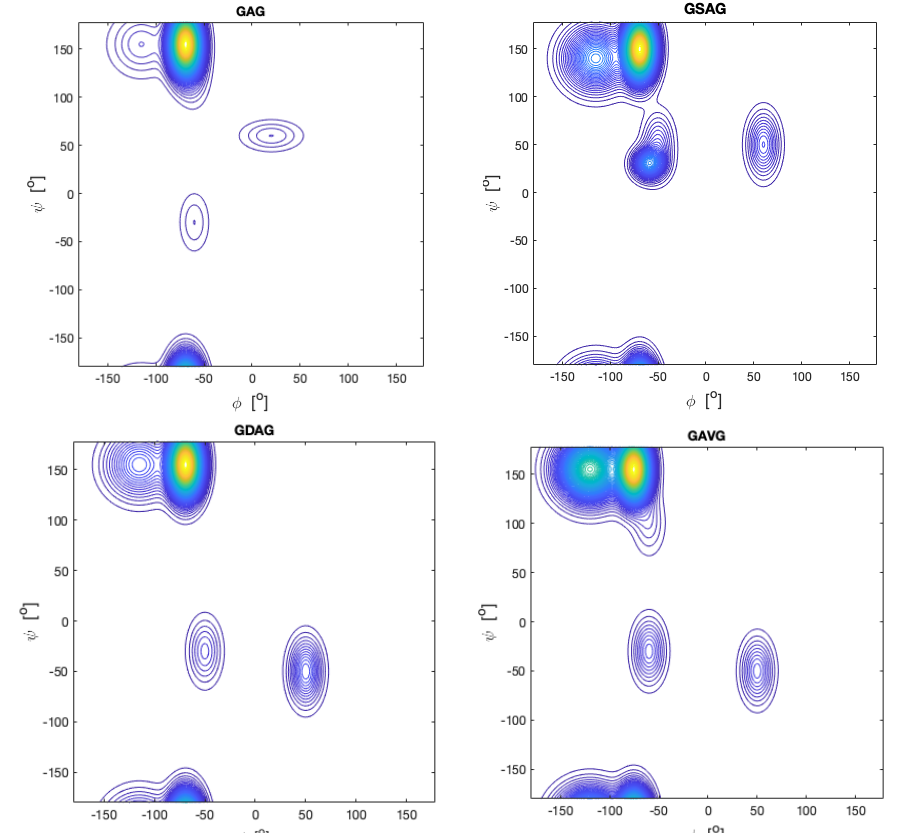
Figure 16. Ramachandran plots of alanine residues in the indicates peptides. Produced with data reported in [99].